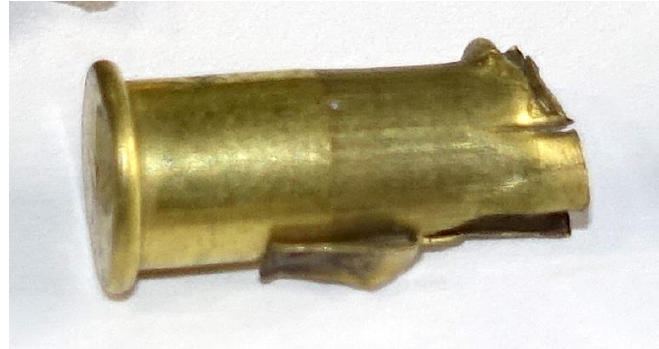
Figure 8. Example of cartridge (AS-head-stamped) post shot that split longitudinally. Note that as in all those that split, the damage terminated at the thicker portion of the case (O.D. Outer Figure 1). Animals 2020 , 10 , x